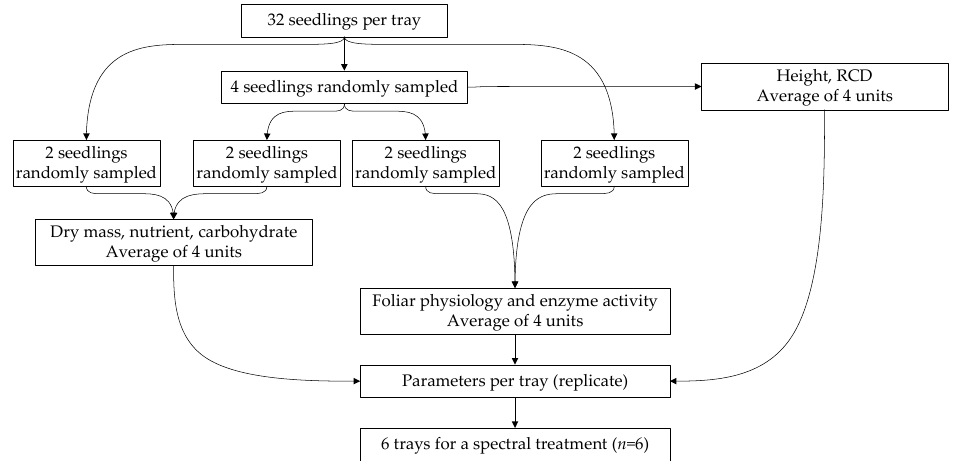
Figure 3. Layout of seedling sampling process and the composition of replicated parameters. RCD: root-collar diameter.